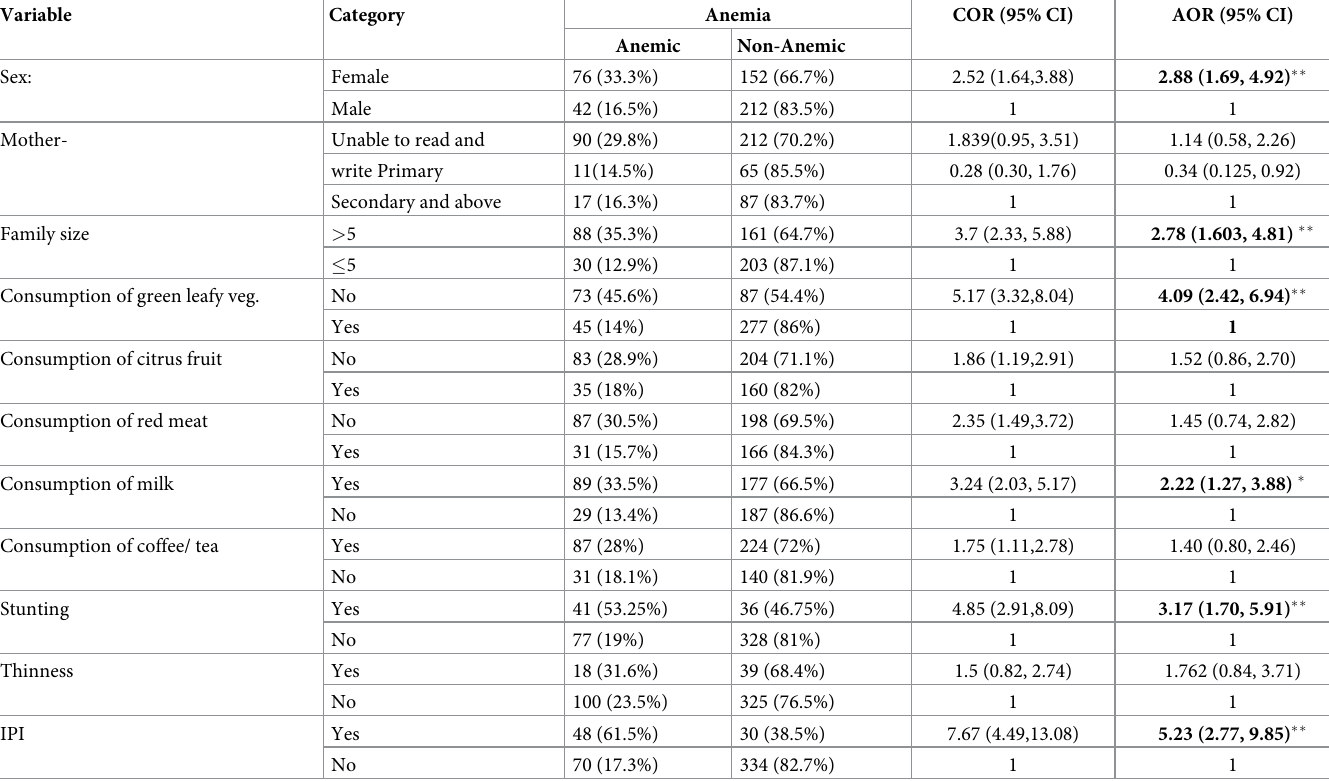
Table 4. Factors associated with anemia among school-children in Kersa Woreda primary schools, eastern Ethiopia, 2020/21 (n =